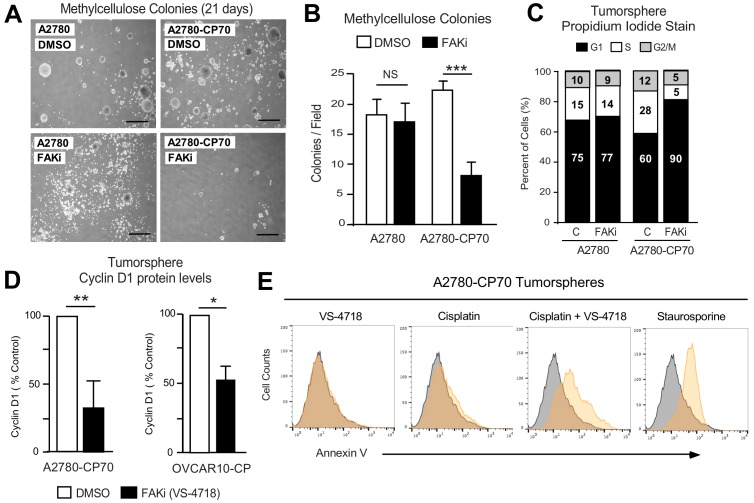
Platinum-resistant A2780-CP70 exhibit FAK-dependent growth.(A) Representative images of A2780 and A2780-CP70 methylcellulose colony formation (21 days) + /- FAKi (1 µM VS-4718). Scale is 2 mm. (B) Quantitation of A2780 and A2780-CP70 colony formation from panel A. Values are means + /- SD from two independent experiments (NS, not significant and ***p<0.001). (C) A2780 and A2780-CP70 cells grown as 3D tumorspheres for 3 days, treated with DMSO or FAKi (VS-4718, 1 µM), stained with propidium iodide, and analyzed by flow cytometry. Percentage of cells in G0, G0/G1, S, and G2-M phase of the cell cycle was determined using FlowJo. (D) Quantitation of cyclin D1 protein levels by immunoblotting of cell lysates from tumorsphere experiment in panel F. Values are normalized to DMSO-treated control and are means + /- SD from three independent experiments (*p<0.05 and **p<0.01). (E) Representative flow cytometry histograms of A2780-CP70 spheroids treated with DMSO (gray) 1 µM VS-4718, 5 µM cisplatin, VS-4718 plus cisplatin, or 1 µM staurosporine for 18 hr (orange) and analyzed for annexin V binding.